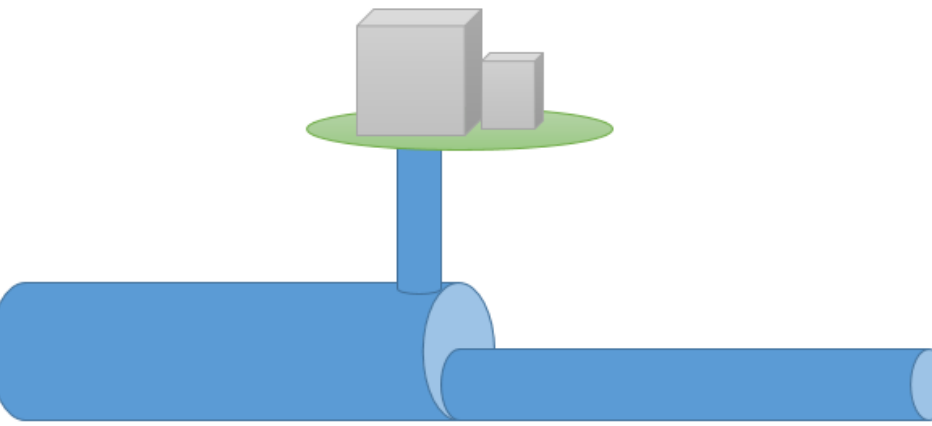
Figure 4. House junction point—dimension concept of a pipe before and after the connection to a house: change in pipe